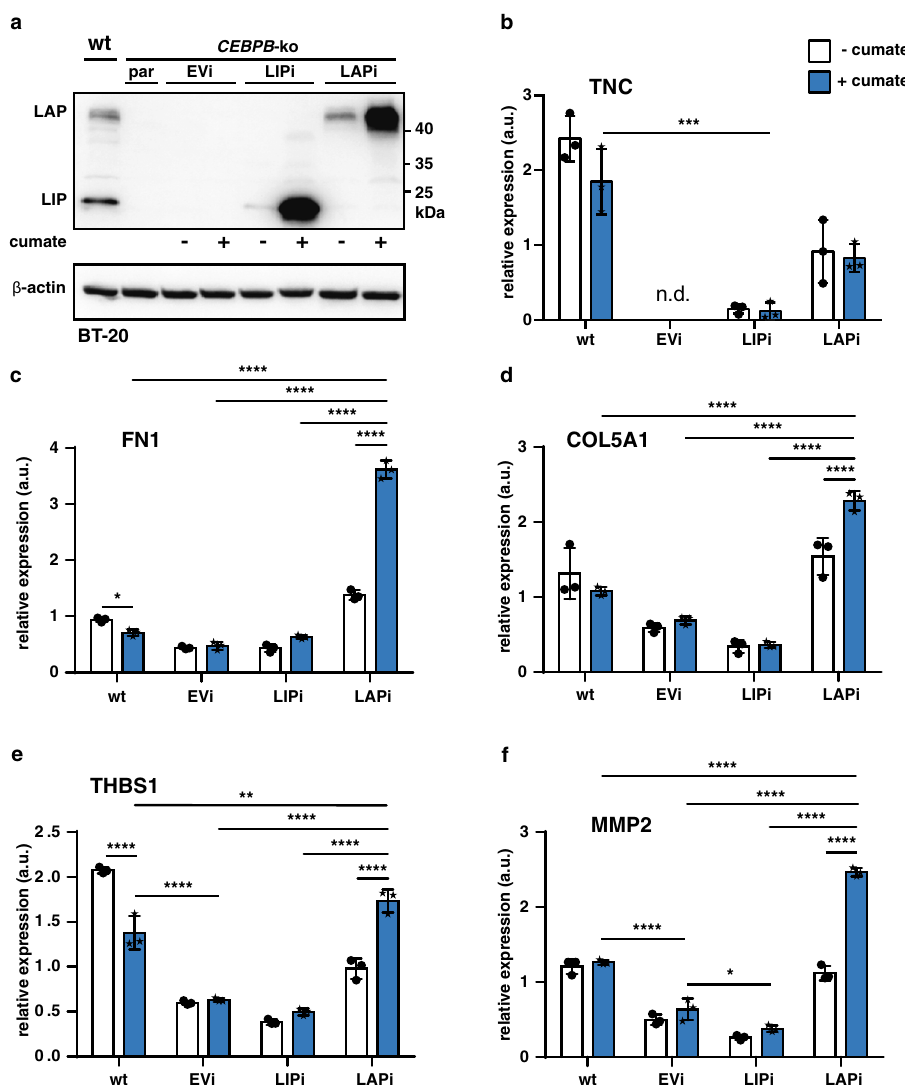
Fig. 7 LAP induces the transcription of ECM components. a Immunoblot showing the expression of LAP and LIP and β -actin as loading control in BT-20 CEBPB -ko clone #7 transduced with expression vectors for cumate-inducible LIP and LAP expression ( n = 3). b - f Expression of extracellular matrix-associated genes in CEBPB -ko clone #7 upon cumate-induced LIP and LAP expression relative to GAPDH. Differences analysed using a two-way ANOVA analysis and Tukey ’ s multiple comparison test. Error bars represent SD, * p < 0.05, ** p < 0.01, *** p < 0.001 and **** p <